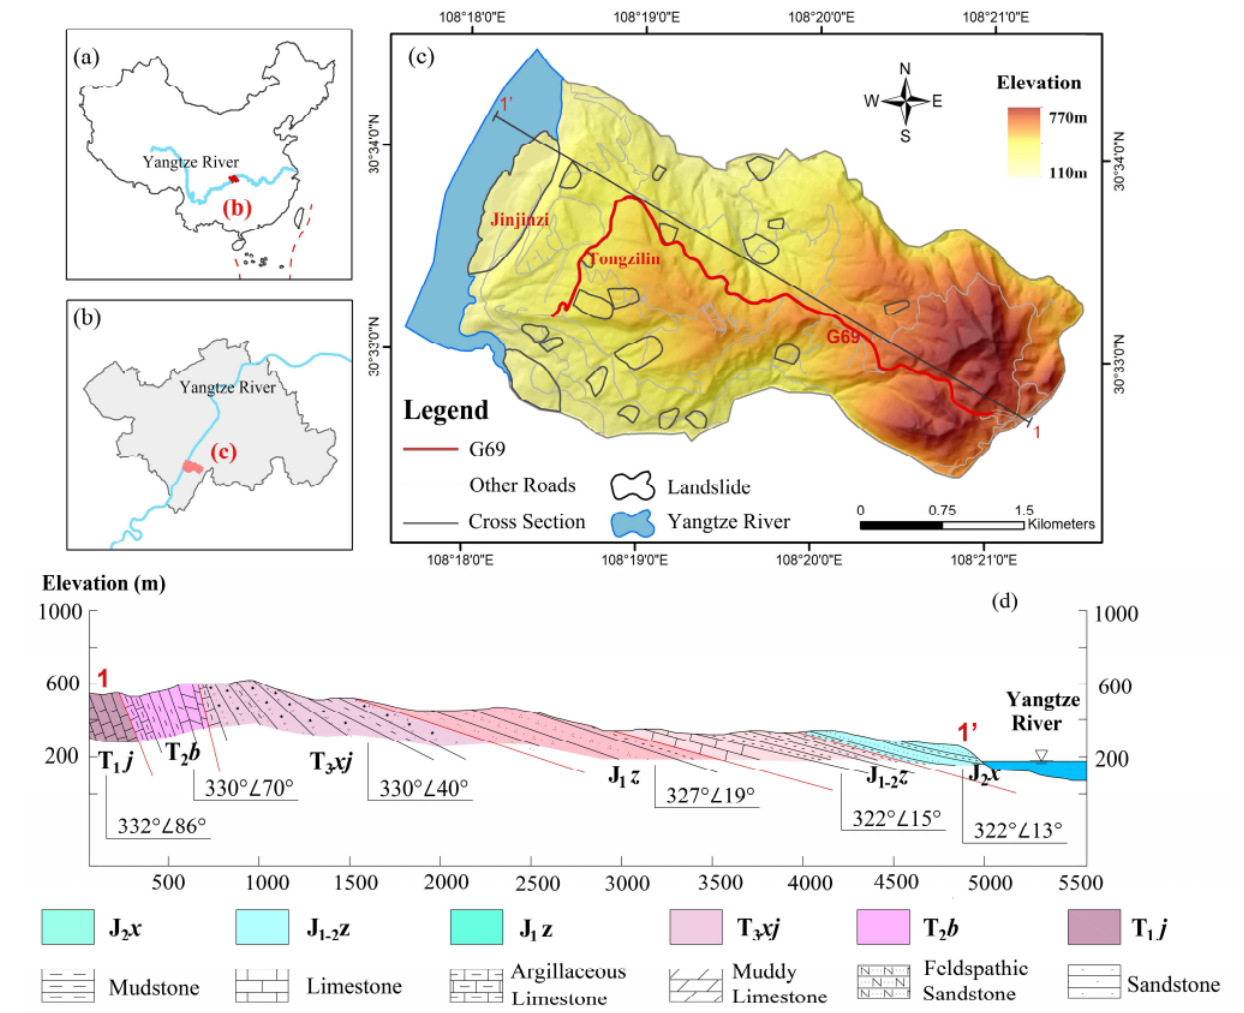
Figure 1. ( a ) The map of China; ( b ) The map of Wanzhou; ( c ) Landslide locations of the study area; ( d ) Geological section of 1–1 (cid:48)